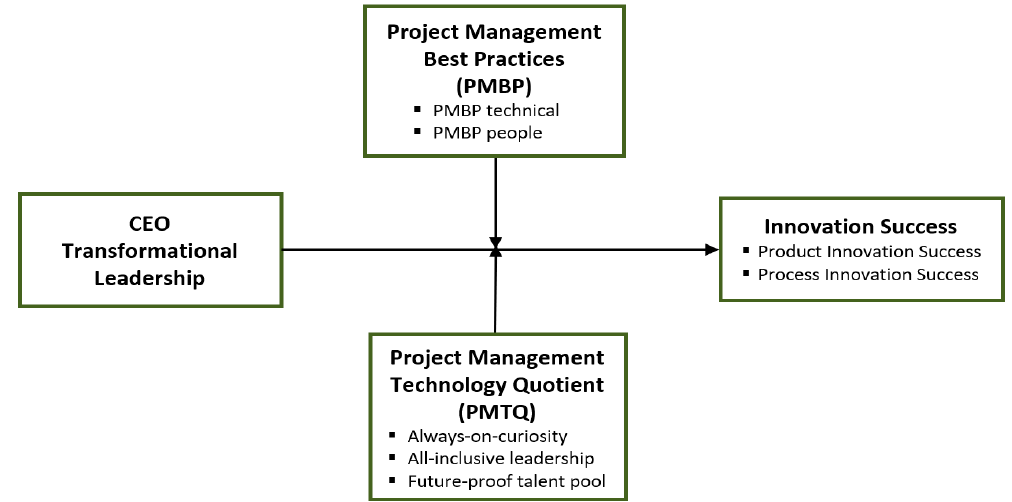
Figure 1. Conceptualized model of innovation success.